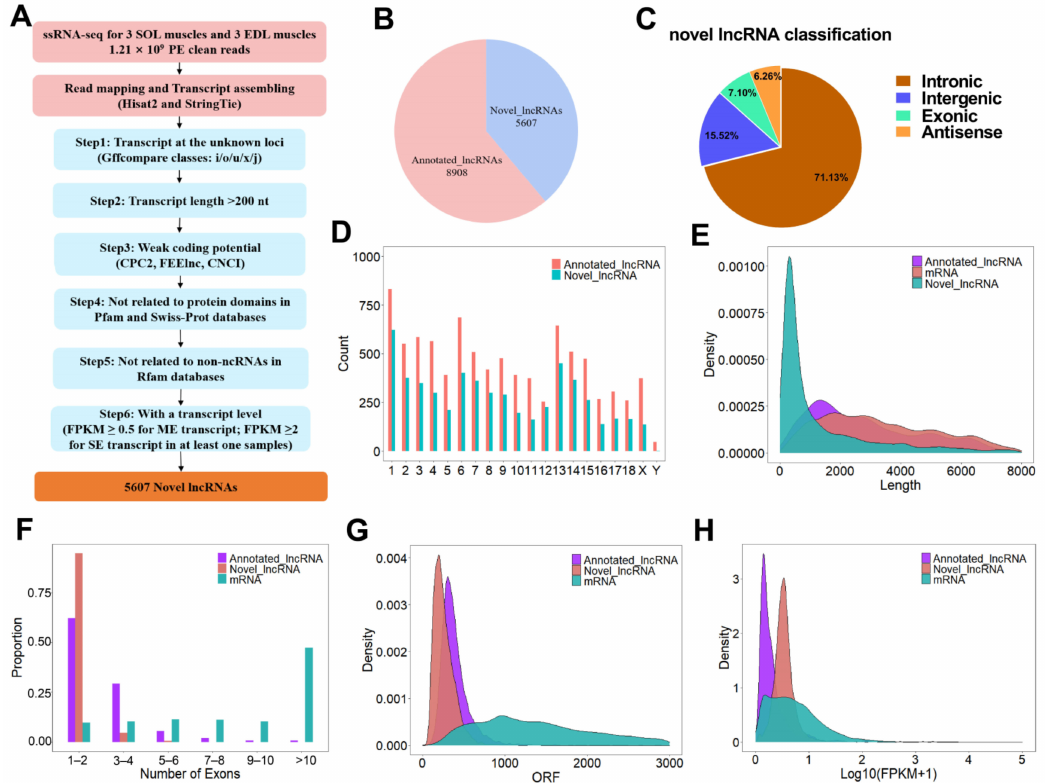
Figure 2. Identification and characterization of lncRNAs identified in SOL and EDL. ( A ) Bioinfor- matics pipeline for novel lncRNAs identification. nt: nucleotide; ME: multiple exons; SE: single exons. ( B ) Pie chart showing the proportion of novel lncRNAs identified in our study and previously annotated pig lncRNAs. ( C ) Classification of novel lncRNAs identified in this study. ( D ) Chromosome distribution of lncRNAs. ( E – G ) Distribution of transcript lengths ( E ), exon number ( F ), ORF length ( G ) in lncRNAs and mRNAs. ( H ) Distribution of expression level (showing log10 (FPKM + 1)) in lncRNAs and